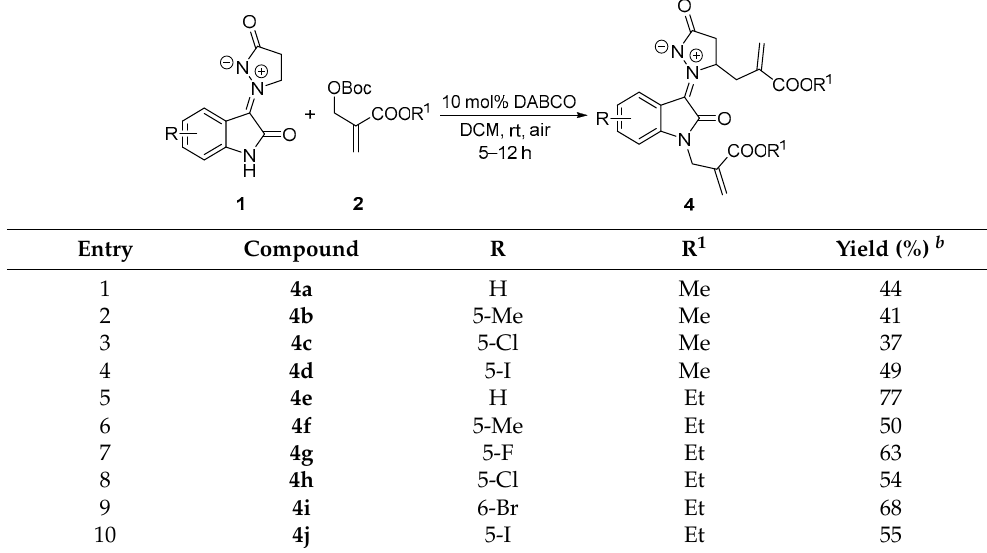
Table 5. Synthesis of N , β -diallylated products 4 from isatin N , N ′ -cyclic azomethine imine 1 and MBH carbonates 2 a